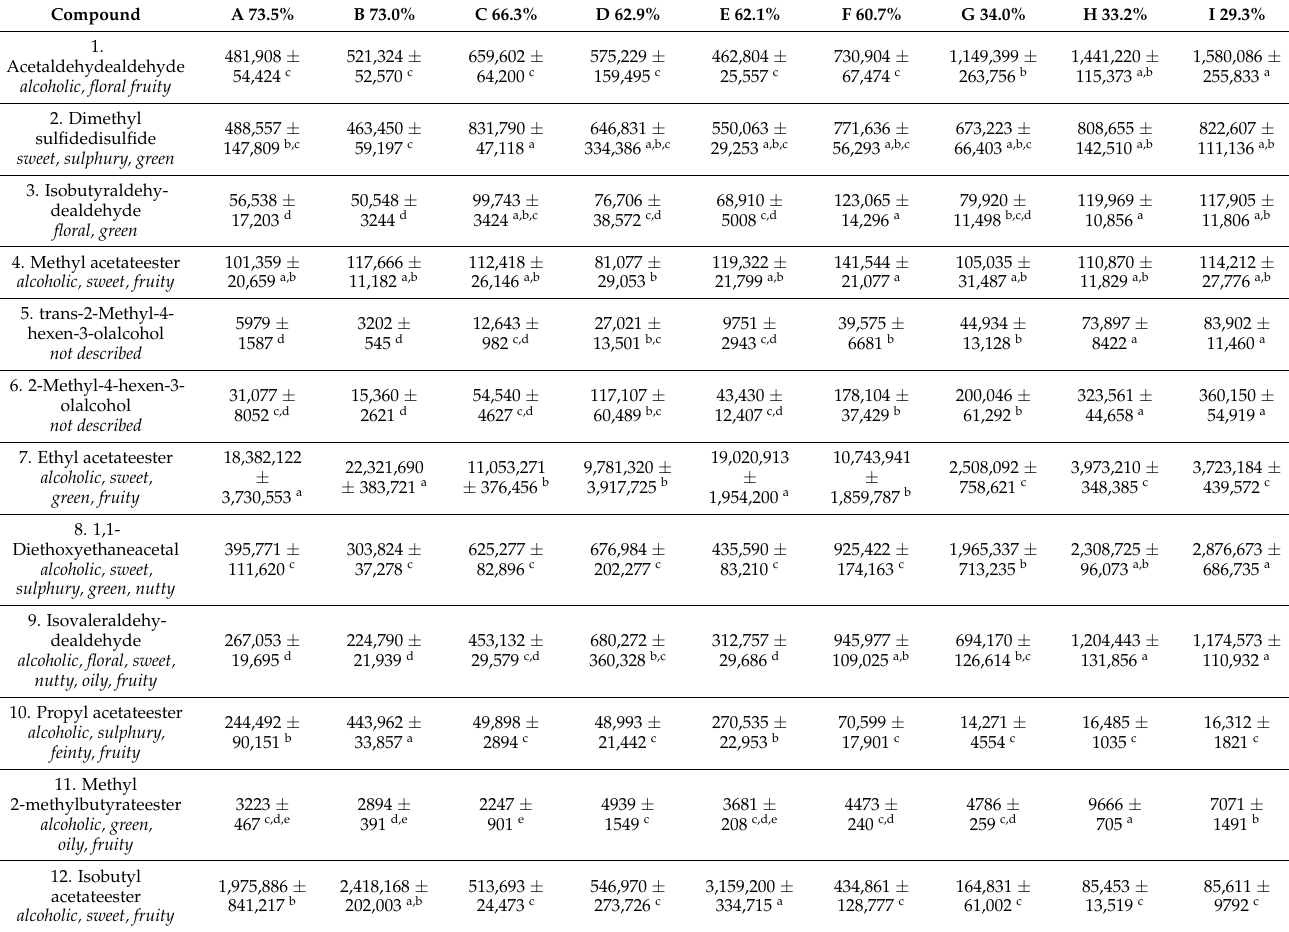
Table A2. Peak areas of detected compounds by GC-MS for nine different new make spirit (mean of four samples measured in duplicate per spirit), standard deviation and Tukey’s groupings (a,b,c,d,e,f). In addition, the chemical group and sensory descriptors of each compound are shown. Sensory descriptors were assigned based on the Good Scents Company websites descriptors and grouped according the SWRI flavour